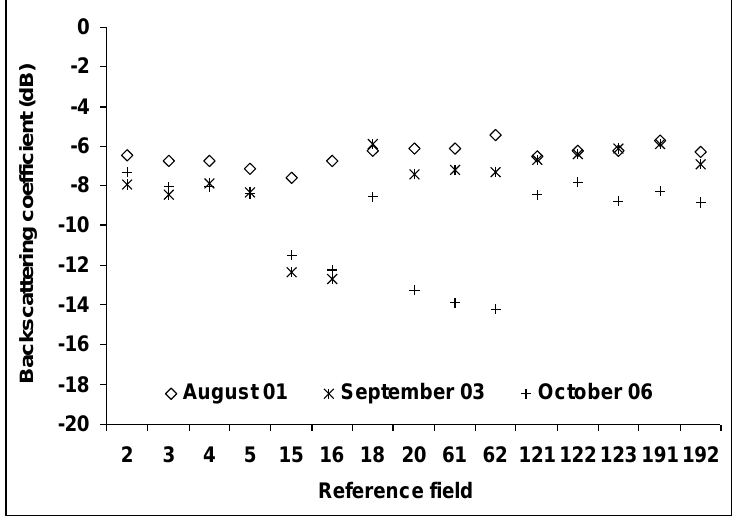
Figure 9. Backscattering coefficient extracted from TerraSAR images of August 01, September 03, and October 06, 2009 (VV-37°). The standard deviation of backscattering coefficients within training fields varies between 1.5 and 2